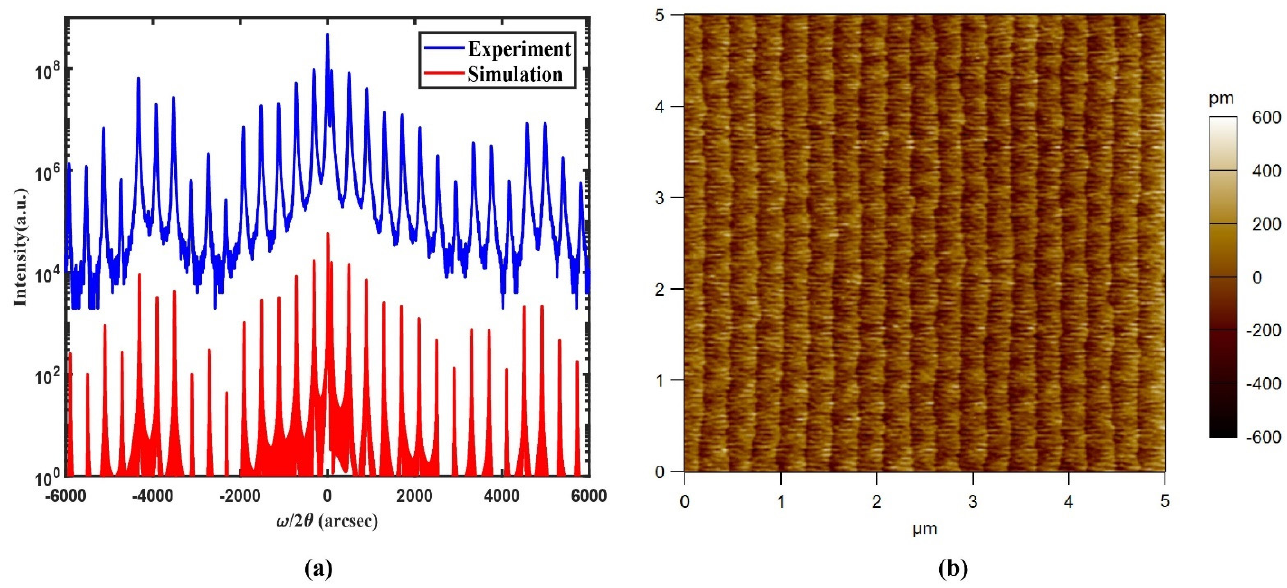
Figure 2. ( a ) High-resolution XRD of experimental (blue, upper curve) and simulated (red, lower curve) results of strain-balanced QCL structures. ( b ) Atomic force microscopy image (5 × 5 μ m) of 40-period strain-balanced QCL structures.